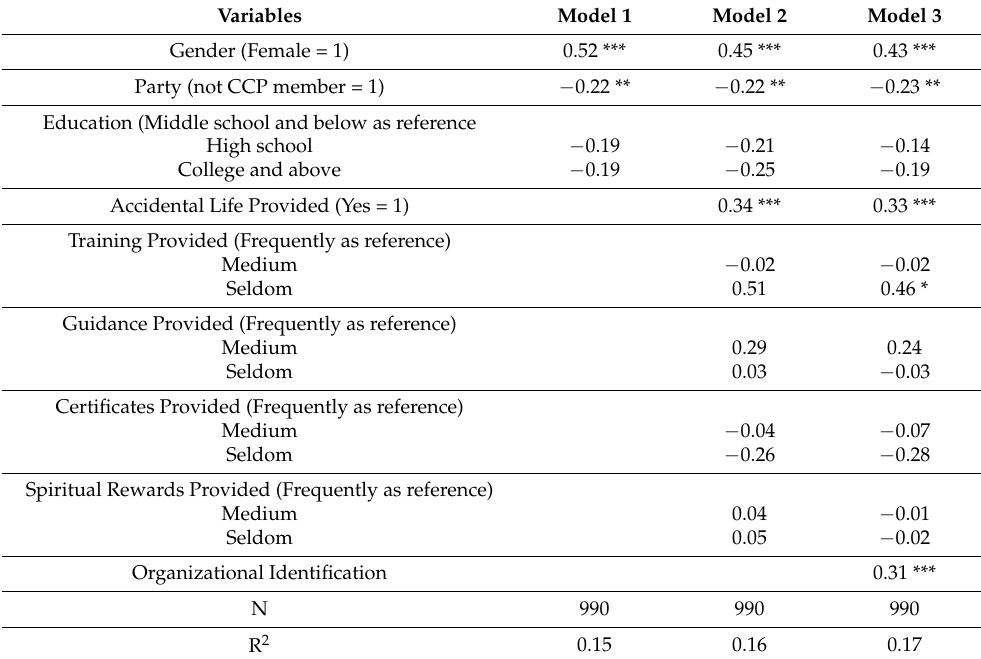
Table 5. Regression